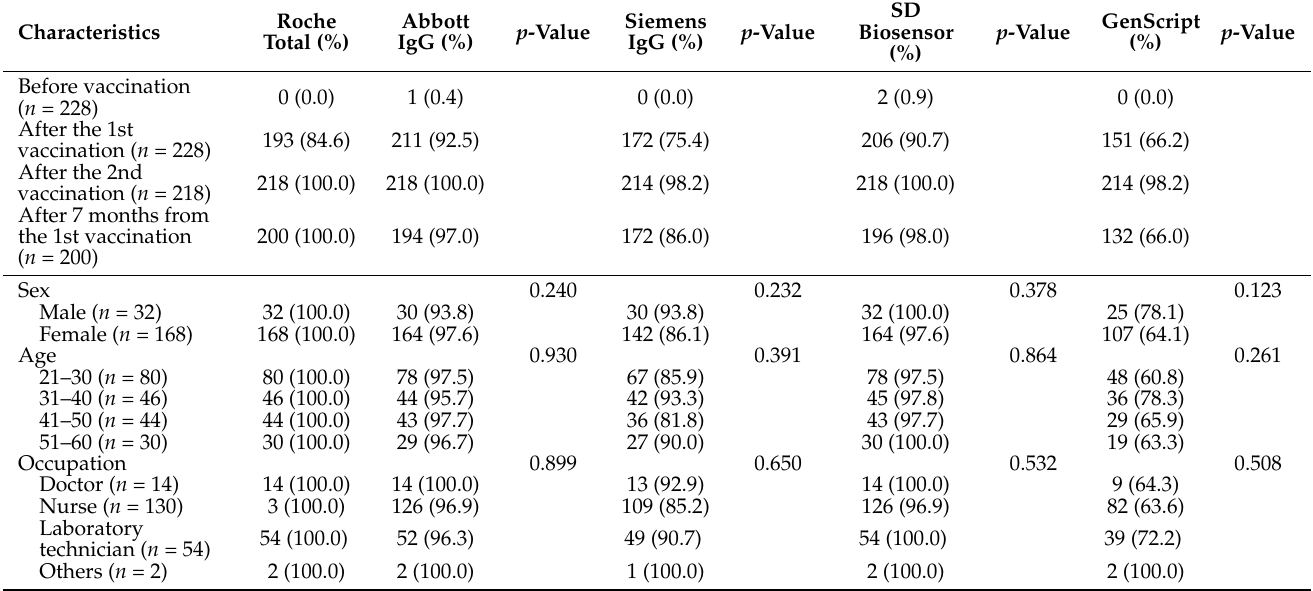
Table 1. Positivity values of severe acute respiratory syndrome coronavirus 2 (SARS-CoV-2) an- tibody assays at 7 months after a ChAdOx1 nCoV-19 vaccination according to the characteristics of